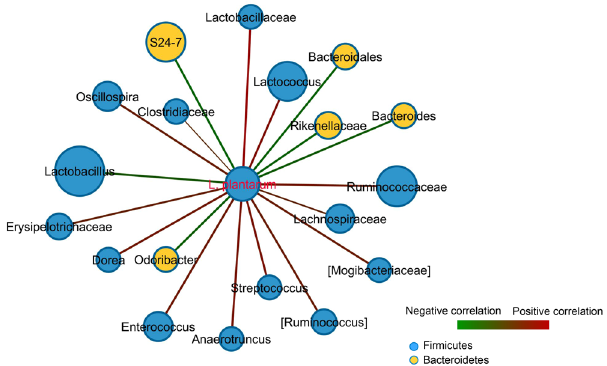
Figure 6. Interactions between L . plantarum and the host indigenous intestinal microbes during all three dietary periods. Each node represents one genus with the color indicating the phylum to which the genus belongs and the size of the node proportional to the relative abundance of that organism in the bacterial community (only taxa with the average abundance over 0.001 are shown). The line between nodes indicates the Spearman correlation and the color intensity indicates the correlation coefficient (red, positively correlated and green, negatively correlated). The weight of the line positively corresponds to the correlation significance. Taxa in brackets are based on annotations suggested by the Greengenes